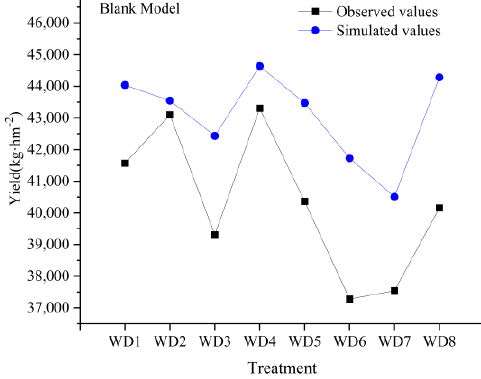
Figure 4. Comparison of observed and simulated values for each model.